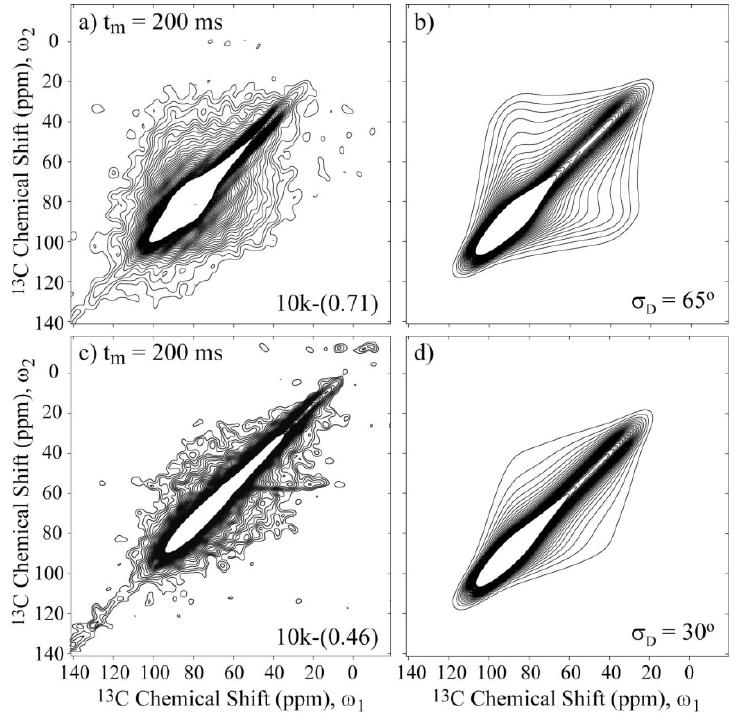
Figure 6. Experimental and simulated 2D Exchange spectra for the ( a ),( b ) 10k-(0.71) sample at T = 20 °C and ( c ),( d ) the 10k-(0.46) sample at T = 100 °C. The simulations were performed assuming rotations around the local chain axis with amplitudes distributed as Gaussian functions with rms values σ indicated in the figures. The orientation of the D chemical shift tensor was assumed to be the same as that of crystalline PEG, and the conformational disorder was considered by calculating the reorientation angle distribution from the rotation angle distribution according to reference [36]. The temperatures were selected to ensure that the samples were in the same dynamic regime; see Figure